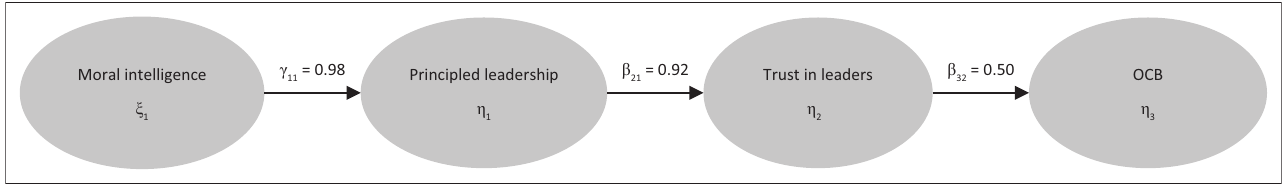
OCB, organisational citizenship behaviour. FIGURE 1: Relationships among moral intelligence, principled leadership, trust and organisational citizenship behaviour.